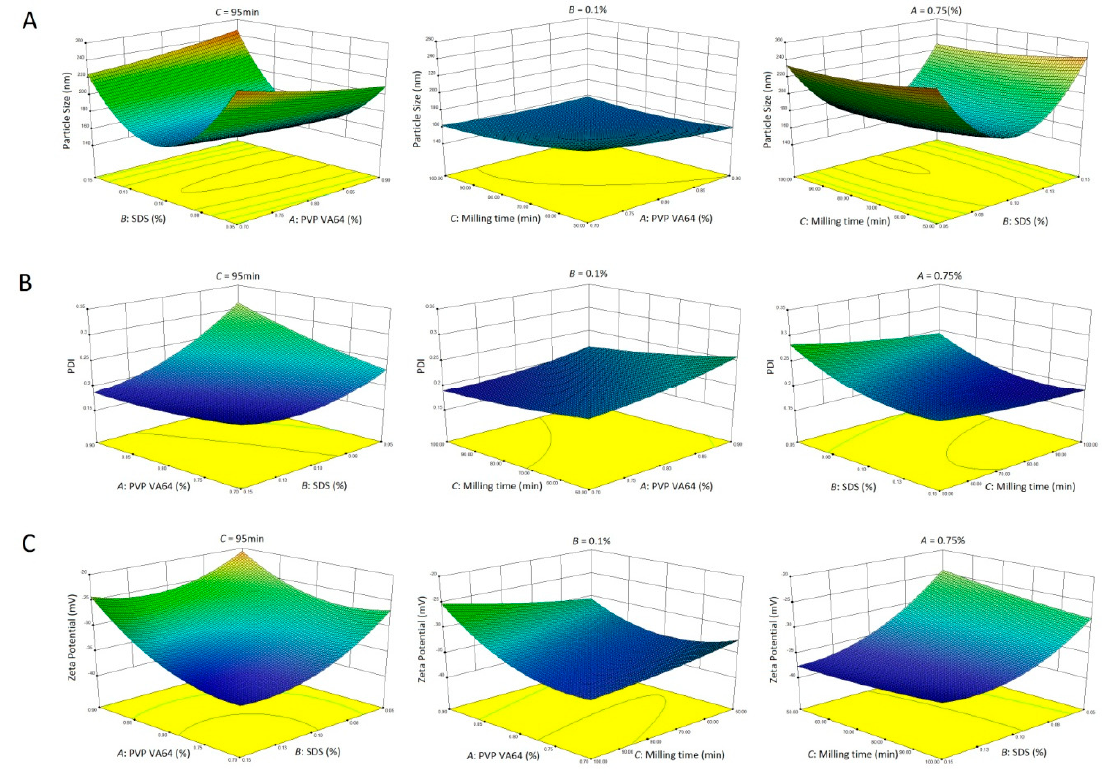
Figure 2. Response surface profiles showed the effects of polymer concentration (X 1 ), surfactant concentration (X 2 ) and the milling times (X 3 ) on ( A ) particle size,( B ) polydispersity index (PDI) and ( C ) zeta potential of CLX-NC.